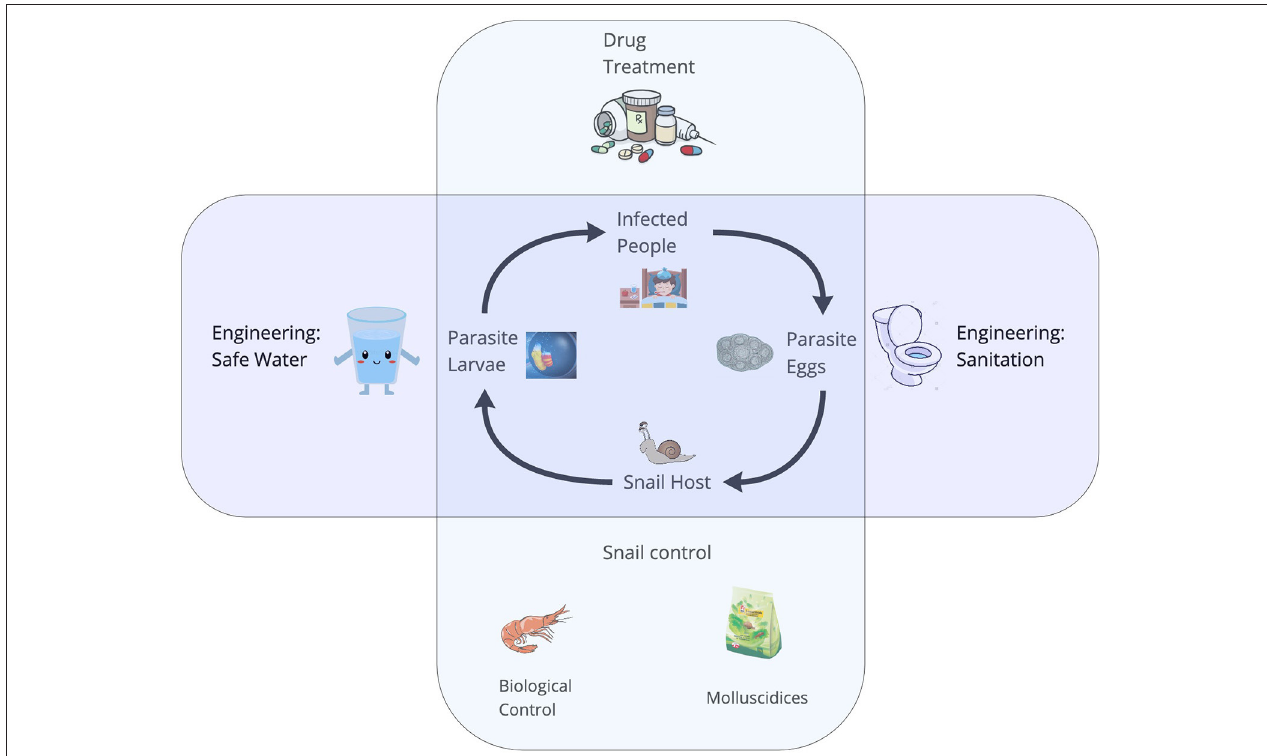
FIGURE 1 | The life cycle of Schistosoma spp. The adult worms live and reproduce sexually within the human host and their eggs are released in the feces. In the environment, eggs must reach the water, and under appropriate conditions miracidia hatch and seek an intermediate freshwater snail host in the surroundings. The larval stages of the worms develop via asexual reproduction. Cercariae are the free-swimming larvae that are released from the snails and seek human hosts, completing the